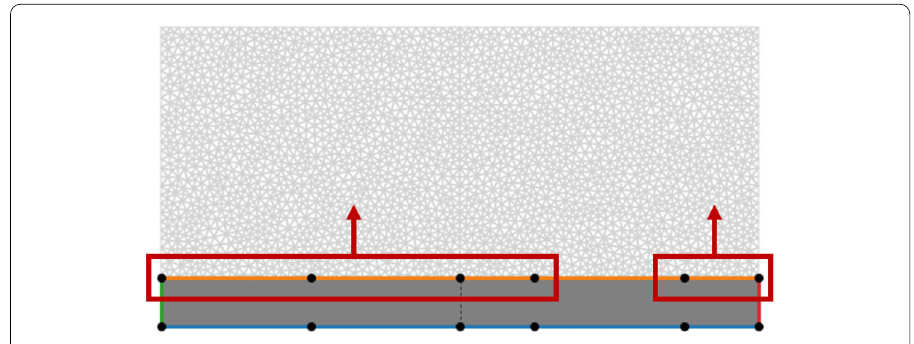
Fig. 6 Example of the isotropic plain specimen: definition of the two design variables. First design variable: displacement along y of the 4 left control points. Second design variable: displacement along y of the 2 right control points. A C 0 line was added at x = 100 mm. In light gray, the initial shape ( h ( x ) = 100 mm ) and; in dark grey, the result of the optimization process ( h opt ( x ) = 16 . 67 mm )